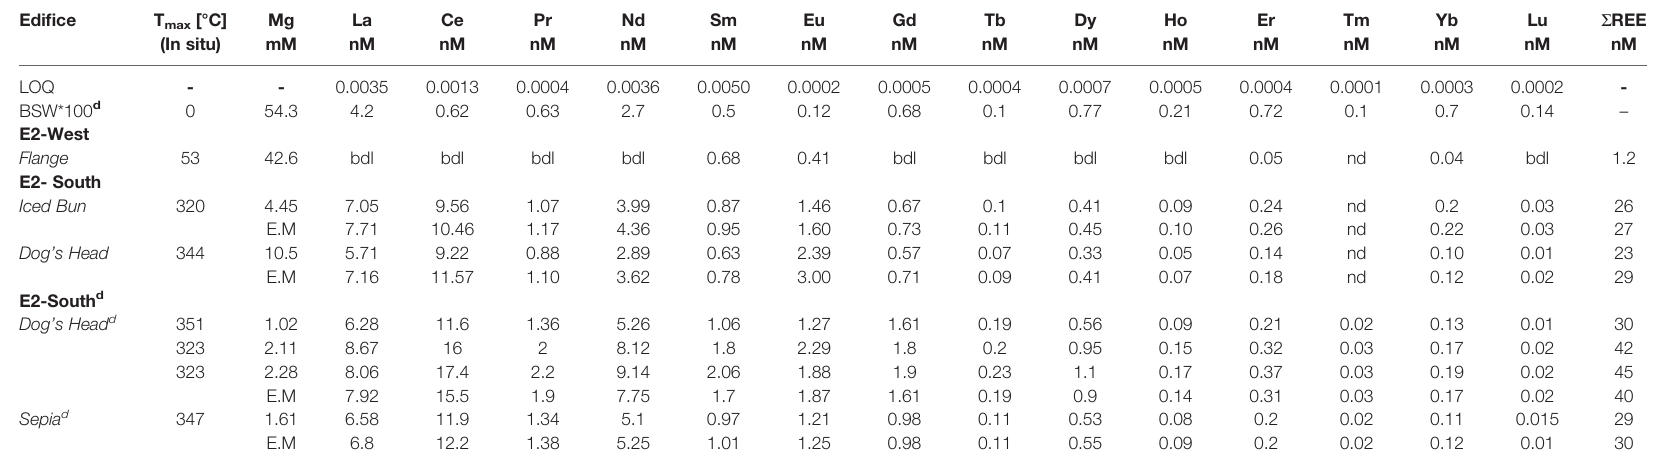
TABLE 3B | Rare-earth element concentrations of the fl uids from E2-S and E2-W hydrothermal vent fi elds. Edi fi